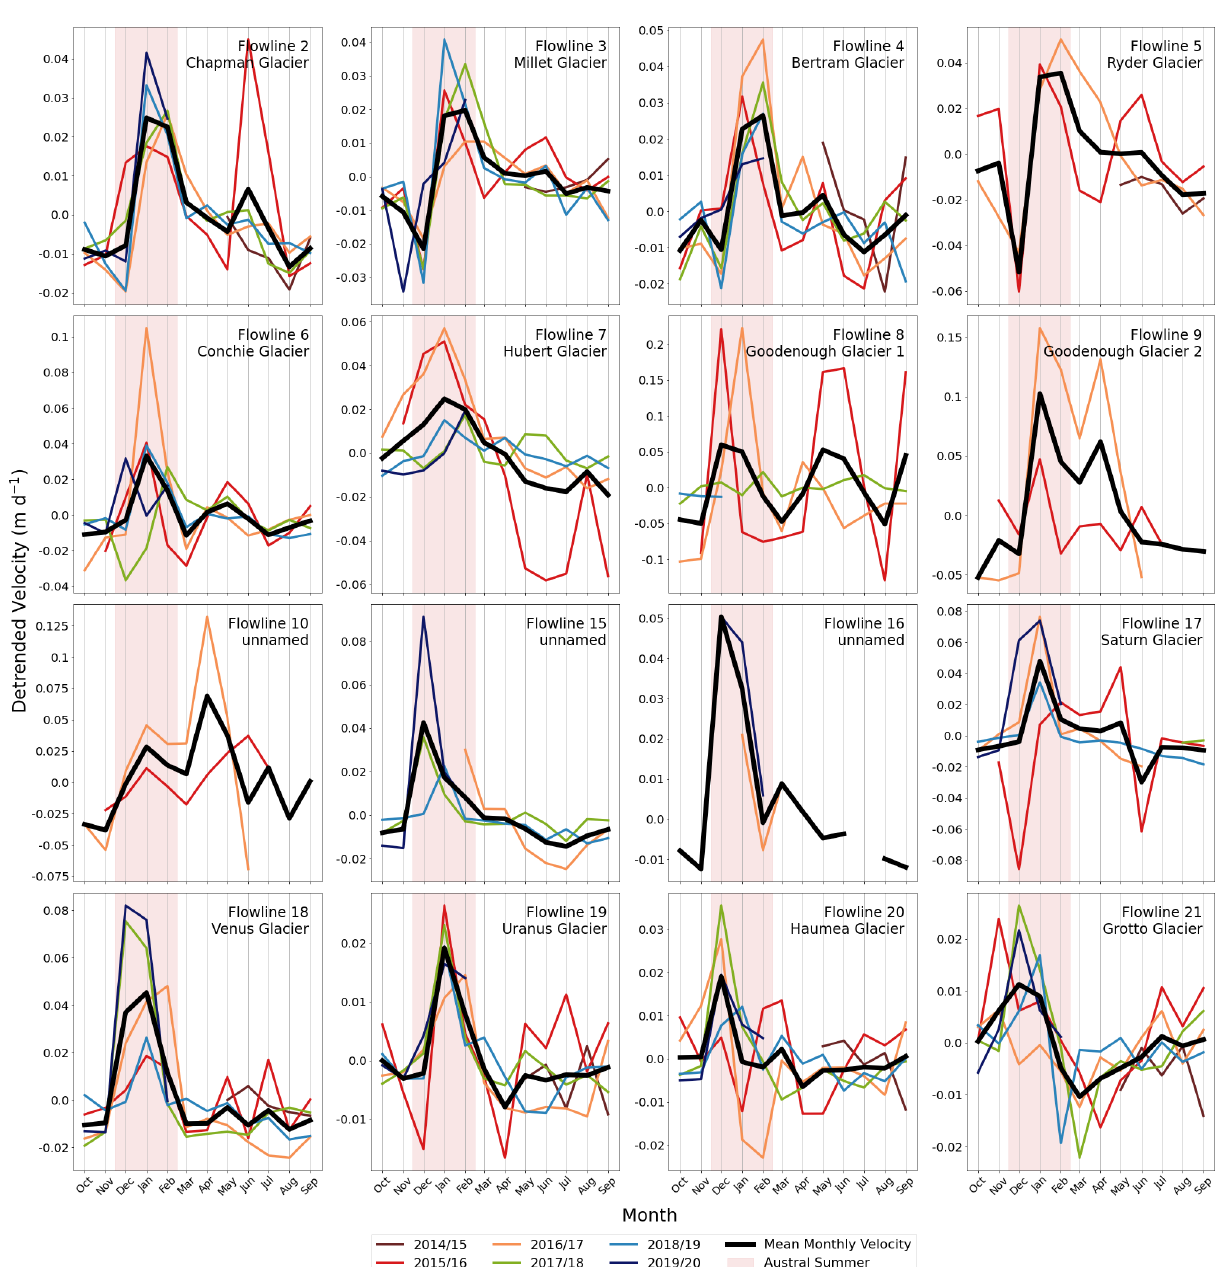
Figure C1. Detrended SAR-derived observations of mean monthly ice flow for each year between 2014 and 2020 (coloured lines) and the mean monthly ice flow calculated over the entire time series (black line; same as Fig. 5). Observations are averaged across the 10km 2 dashed boxes shown in Fig. 1. Translucent red shading denotes the timing of austral summertime (December–February, inclusive). Note that the y axis limits vary between